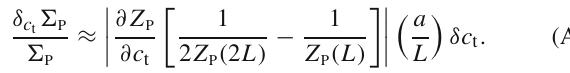
Fig. 7 Variation of Z P with the value of the boundary improvement coefficients